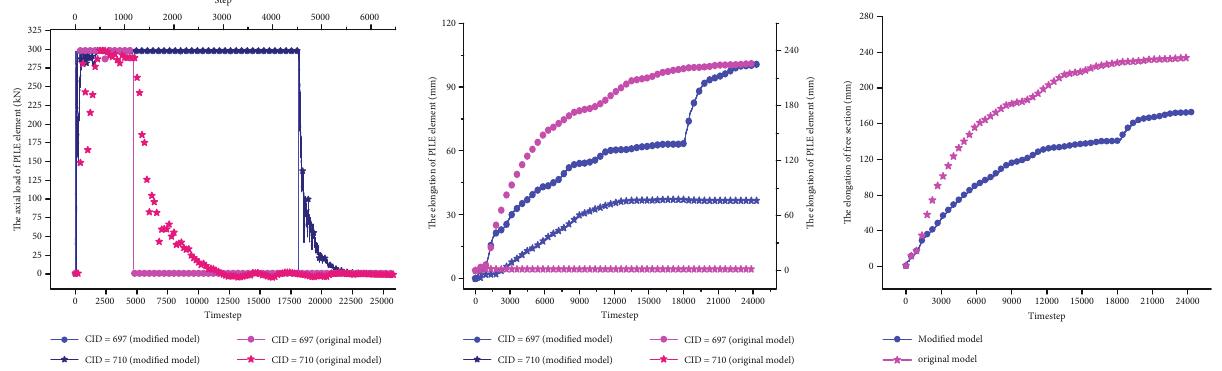
Figure 23: The elongation distribution of rock bolt No. 15 under di ff erent